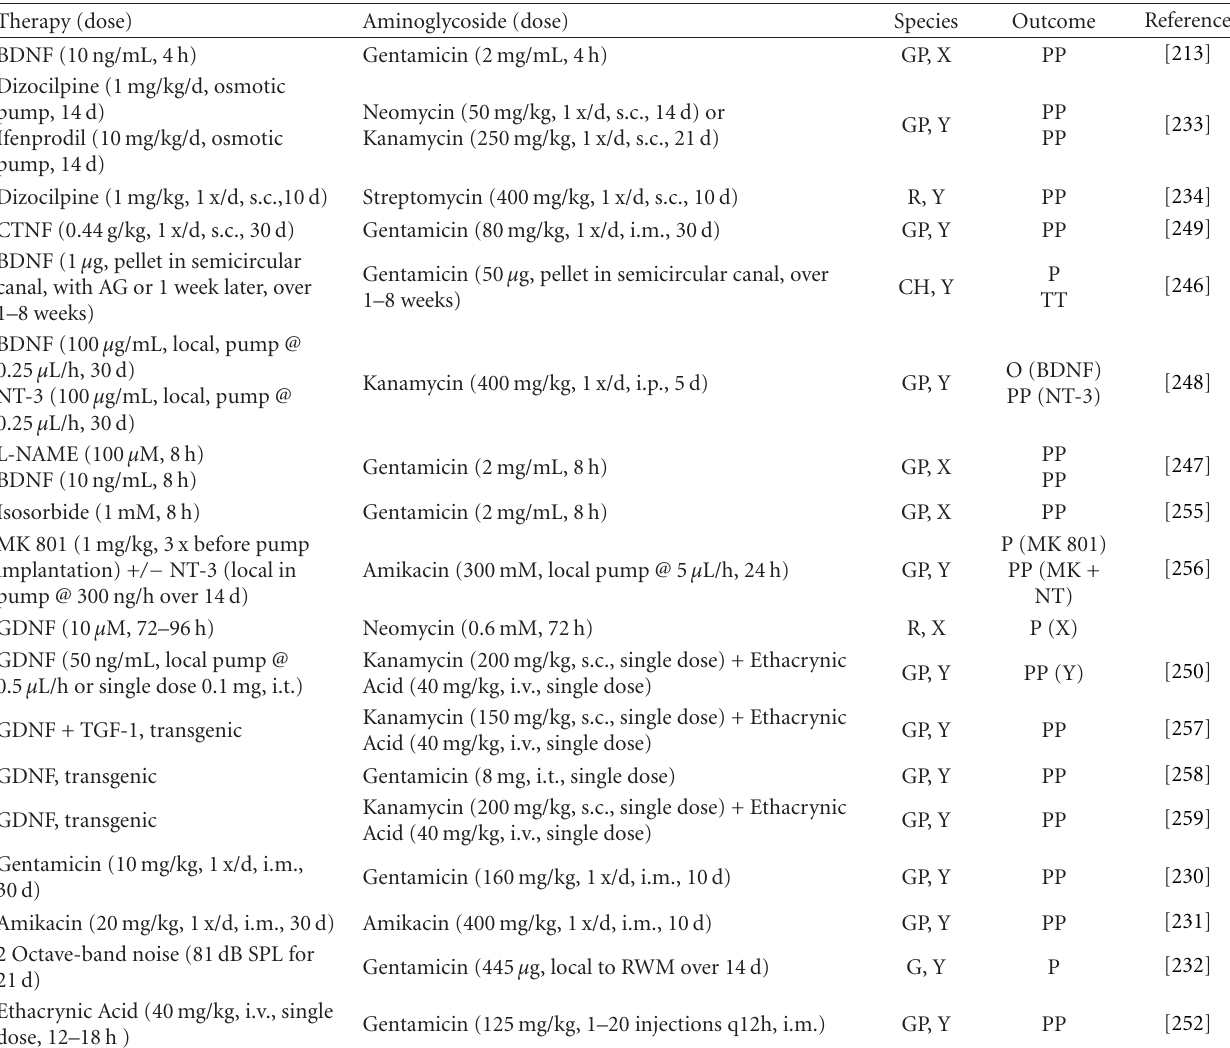
Table 3: Overview of studies with alternative strategies to protect from aminoglycoside ototoxicity. C: Chicken, CH: Chinchilla, G: Gerbil, GP: Guinea Pig, M: Mouse, R: Rat, X: in vitro , Y: in vivo ; i.m.: intramuscular, i.v.: intravenous, i.p.: intraperitoneal, i.t.: intratympanic, s.c.: subcutaneous; d: day, h: hour, q12 h: every 12 h; O: no e ff ect; P/PP/PPP: partial, not significant/partial and statistically significant/complete and statistically significant